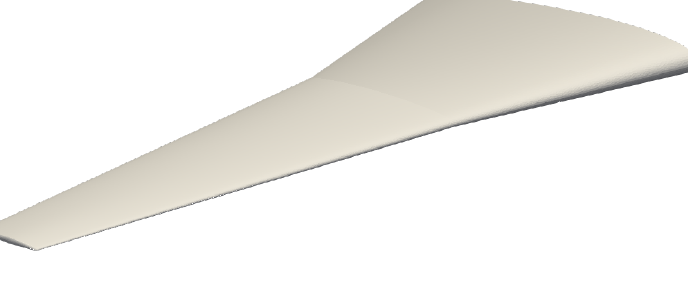
Figure 4. Embraer Benchmark wing